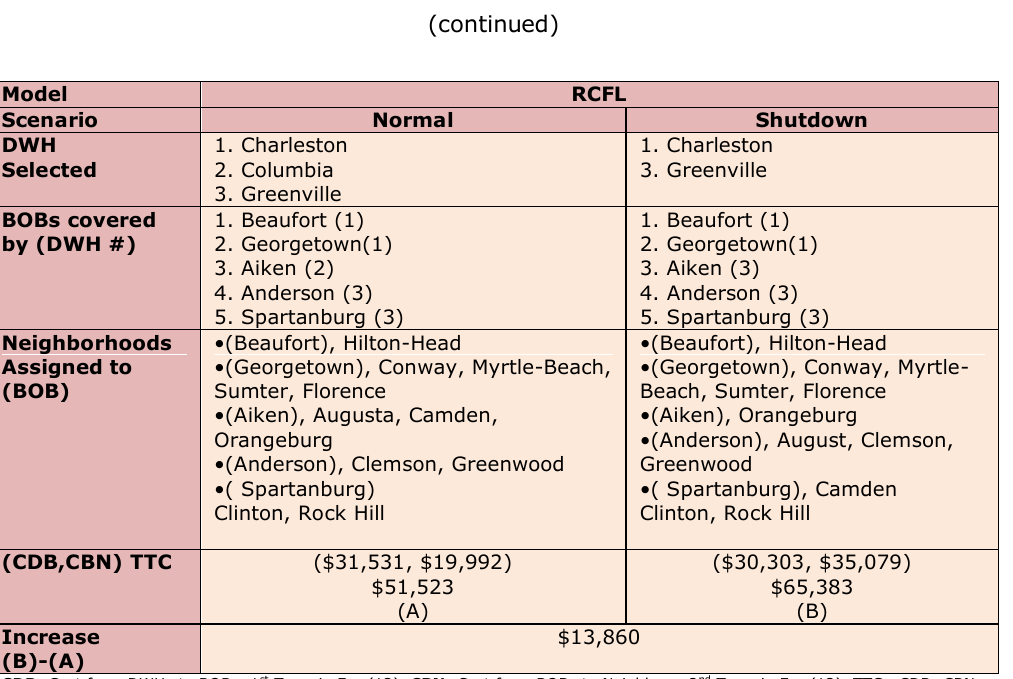
Table 2(b). Results comparison for normal/shutdown scenarios for three models